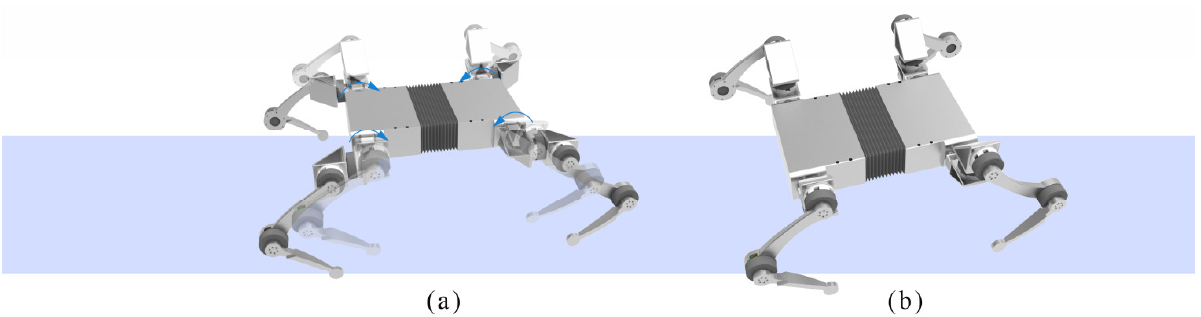
Figure 10. Motion diagram of leg: reptile form to arthropod form: ( a ) Actuator 1 drives the femoral joint to move; ( b ) The robot in arthropod form.